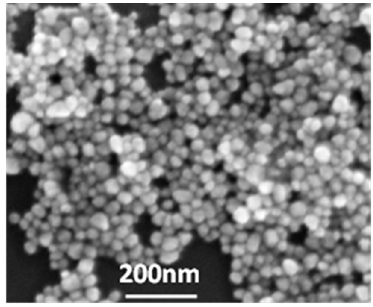
Figure 3. SEM image of silver colloid nanoparticles.